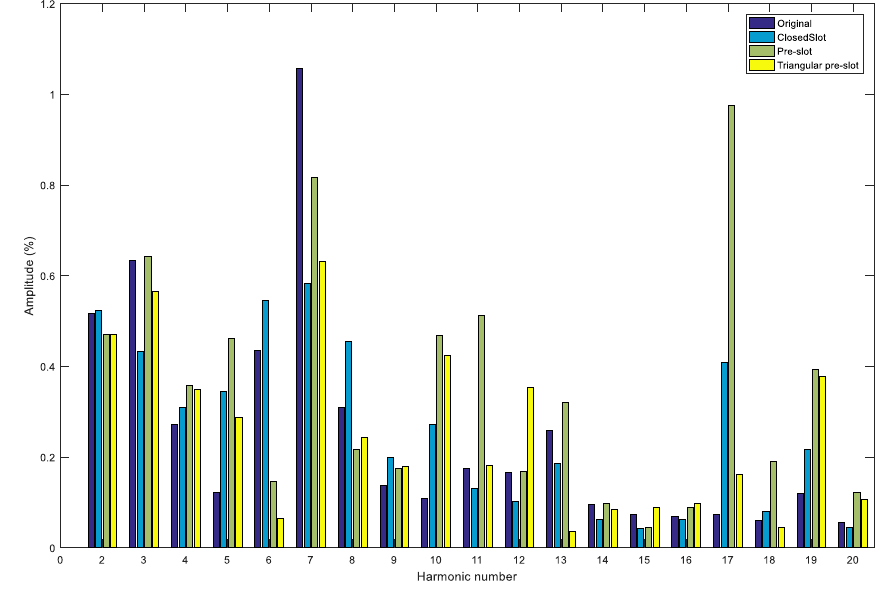
Figure 9. Harmonic spectrum for the proposed reduction method. Table 2. Harmonic distortion rate (THD) of the different